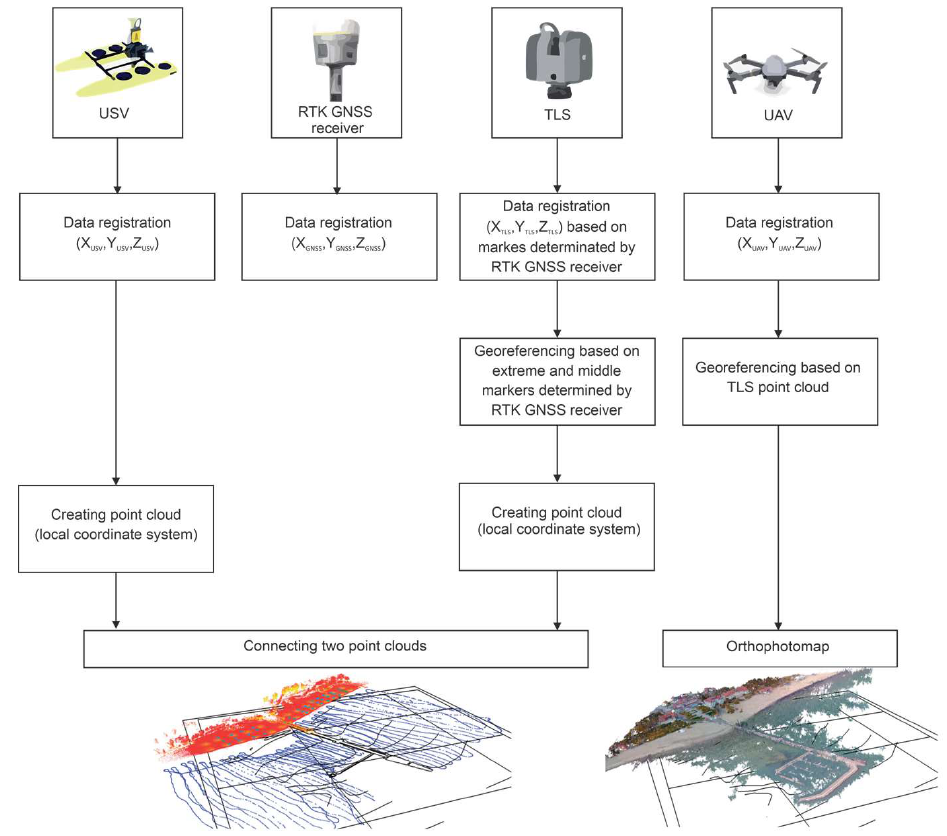
Figure 2 Figure 2. A simplified block diagram presenting the GNSS, TLS, UAV and USV data integration according to